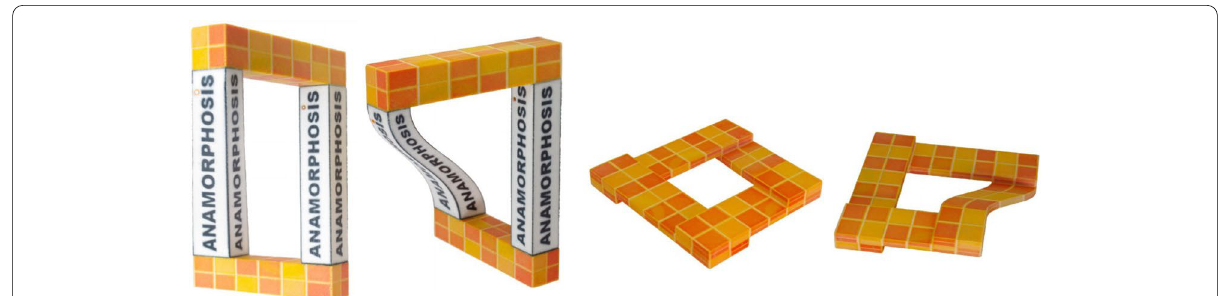
Fig. 32 Two impossible objects of Sánchez‑Reyes and Chacón [78] created using 3D